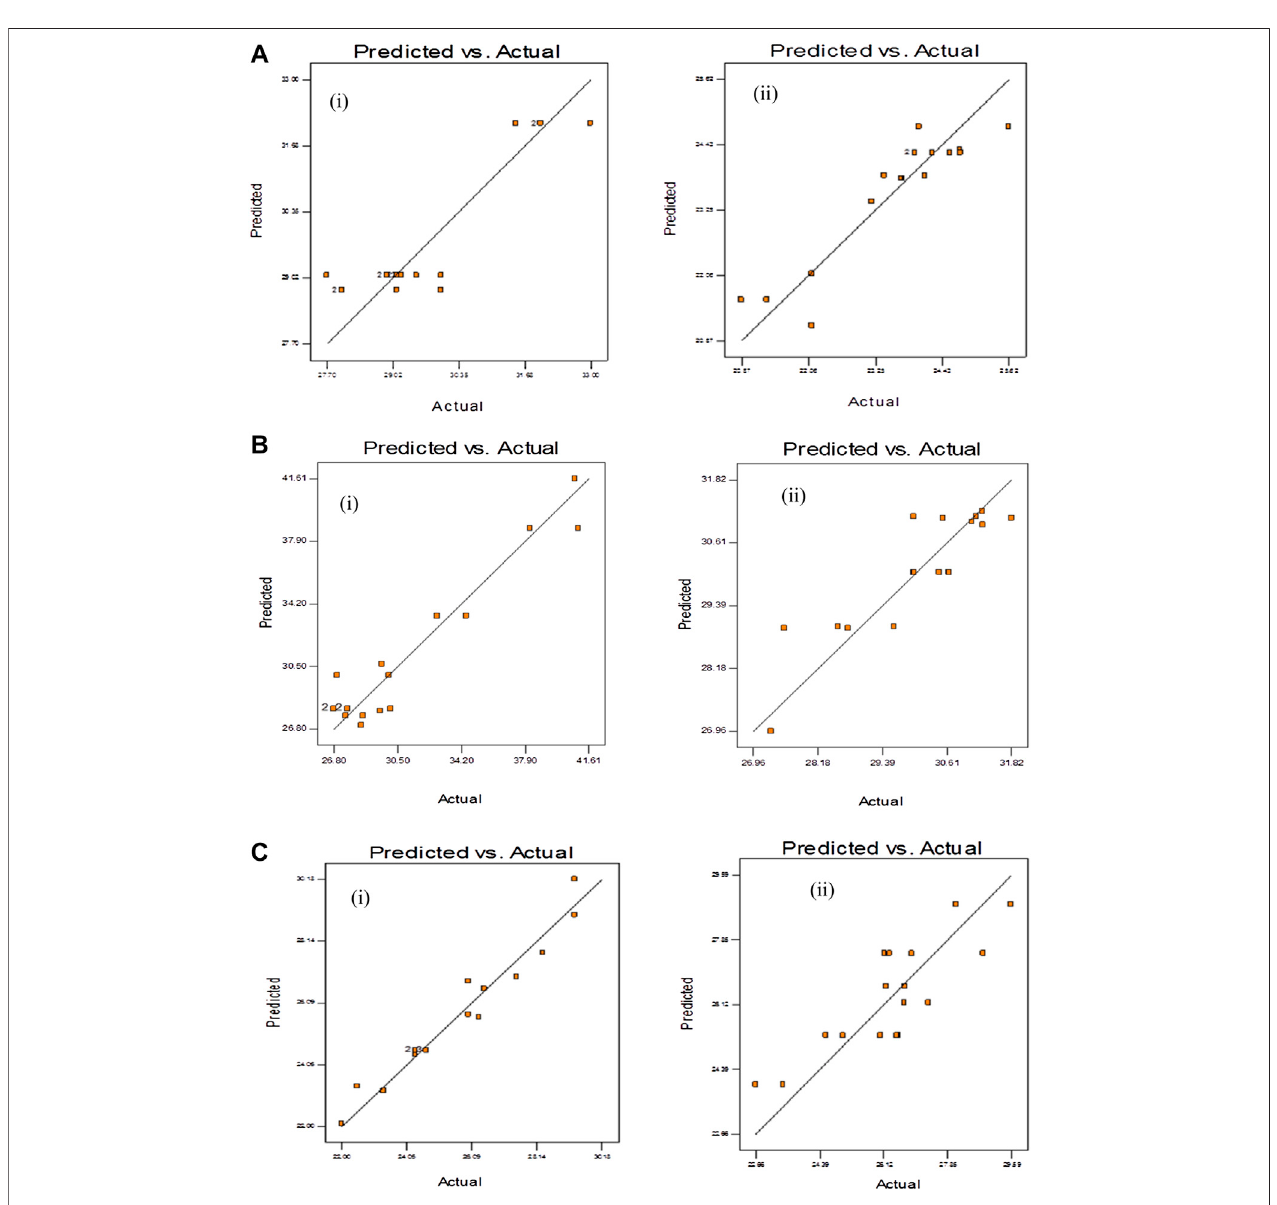
FIGURE7| Predictedvs. actual value of(i)char yieldand (ii) calori fi cvaluefrom the response surface modelofmicrowaveirradiation pyrolysis of (A) PMF, (B) PKS, and (C) EFB.